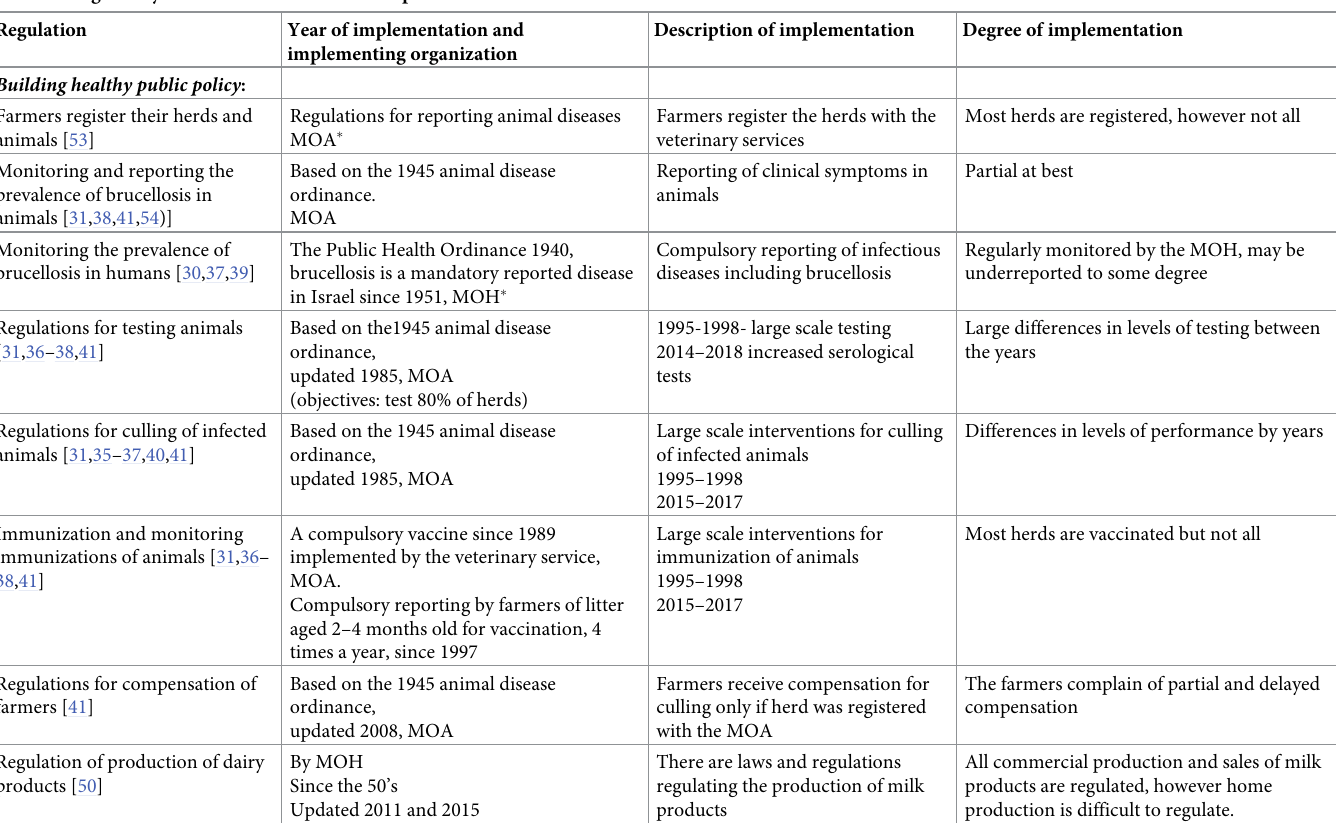
Table 1. Regulatory interventions to control and prevent brucellosis in